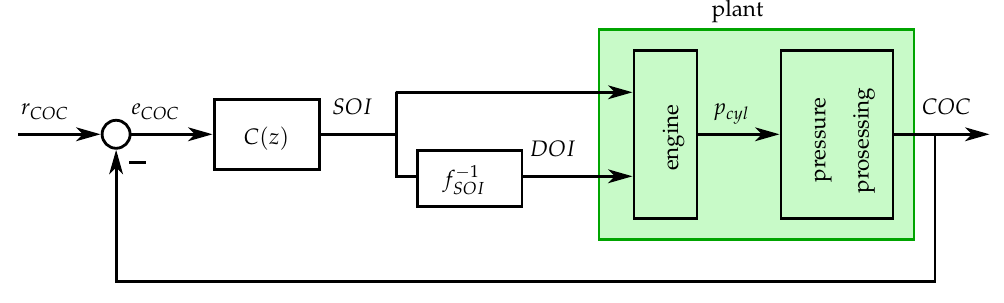
Figure 4. SIMO control—the transformation method.